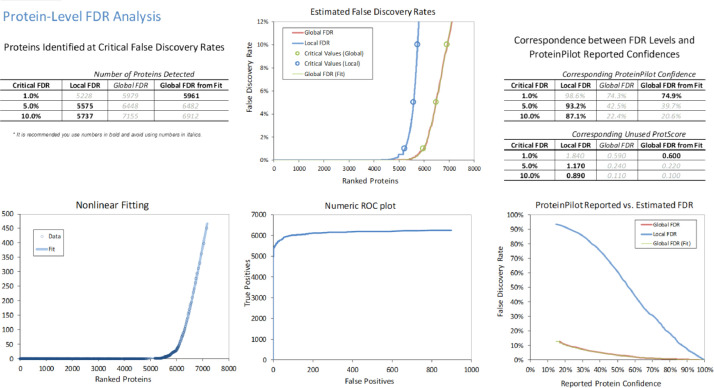
Protein level FDR analysis of retinal IDA library generated by ProteinPilotTM software for SWATH-MS.